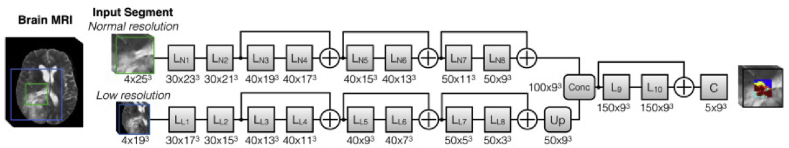
The DeepMedic architecture extended with residual connections. In this architecture residual connections are added between the outputs of every two layers, except for the first two layers of each pathway to direct the network away from raw intensity values (Adapted from Fig1 in Ref. [20].